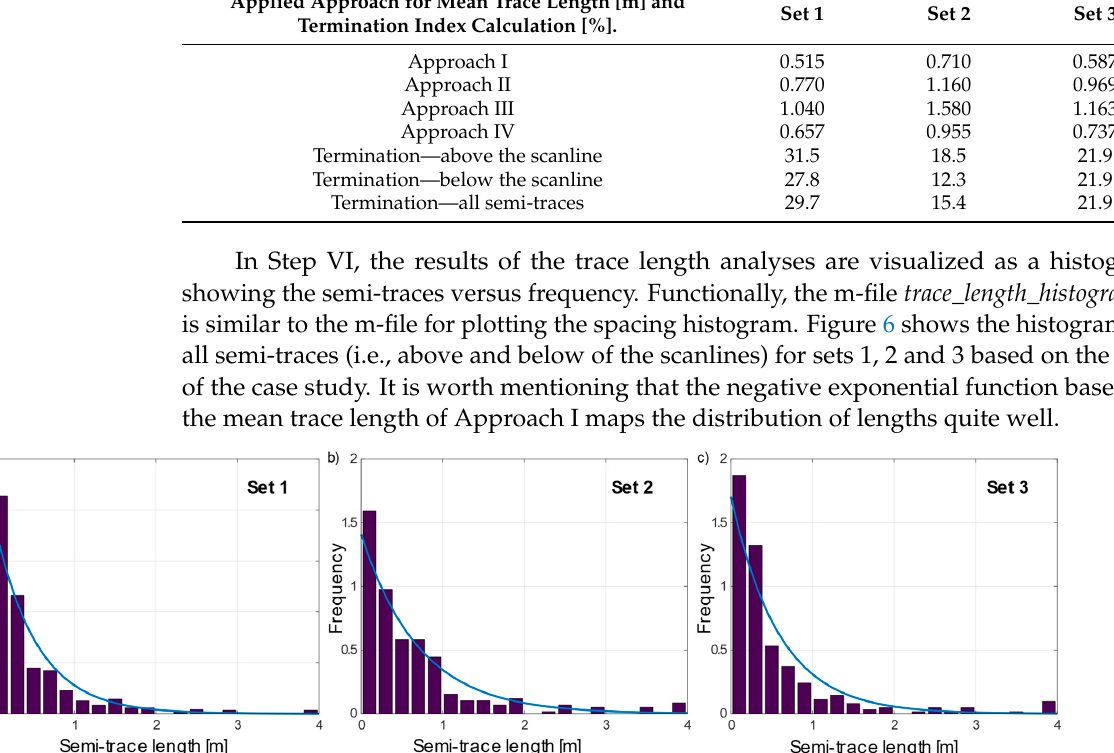
Table 1. Results of trace length and termination index analyses for sets 1, 2, and 3. Applied Approach for Mean Trace Length [m] and Termination Index Calculation [%].